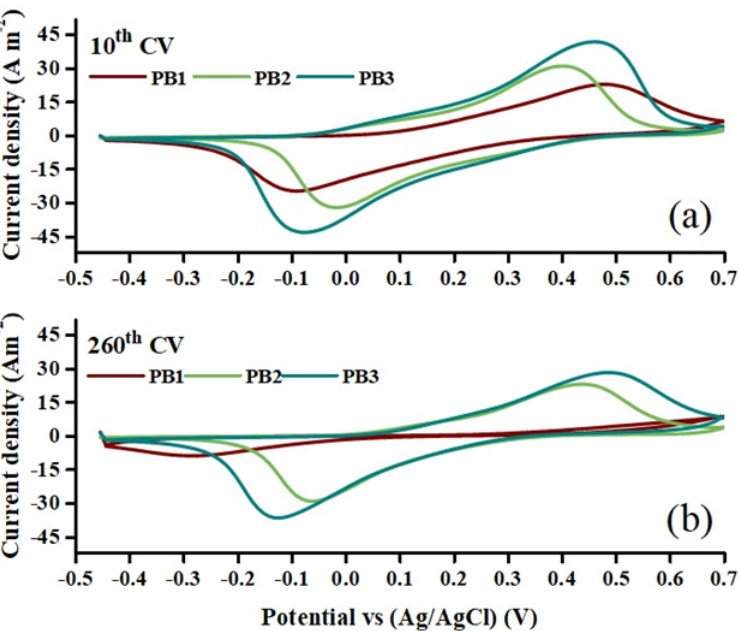
Figure 8. Comparison of the ( a ) 10th and ( b ) 260th cyclic voltammograms of the PB films, recorded in a solution containing 0.1 M HNO 3 and 0.1 M KNO 3 , at scan rate of 100 mV s −1